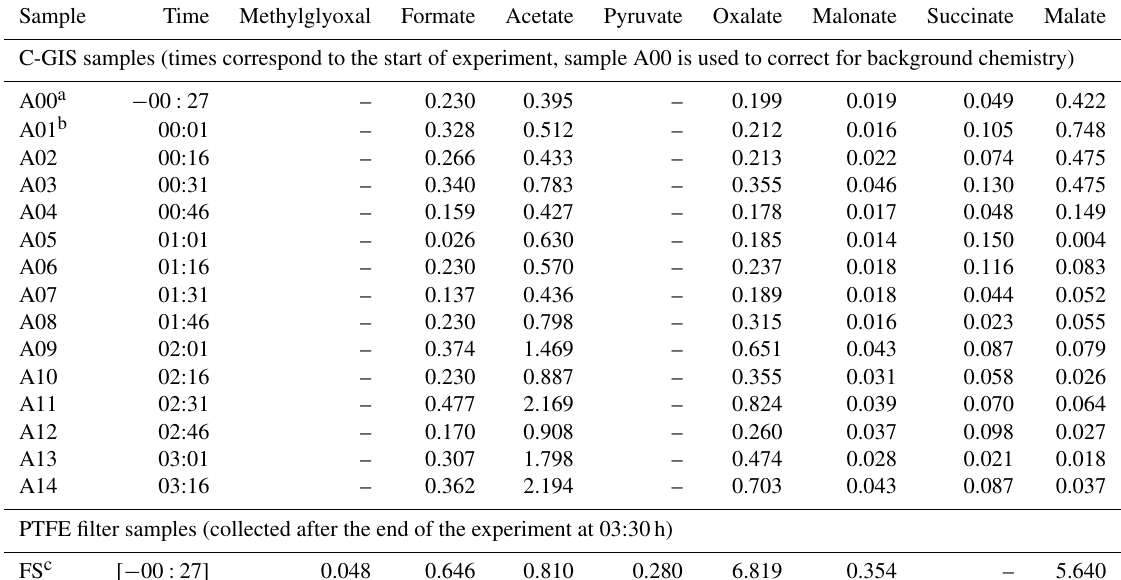
Table 3. Measured uncorrected concentrations in micrograms per cubic metre (µgm − 3 ) from C-GIS and the PTFE filter samples for identified products. Times given in the first column refer to measurement points in hours and minutes after the injection of ozone and the start of the UV-C